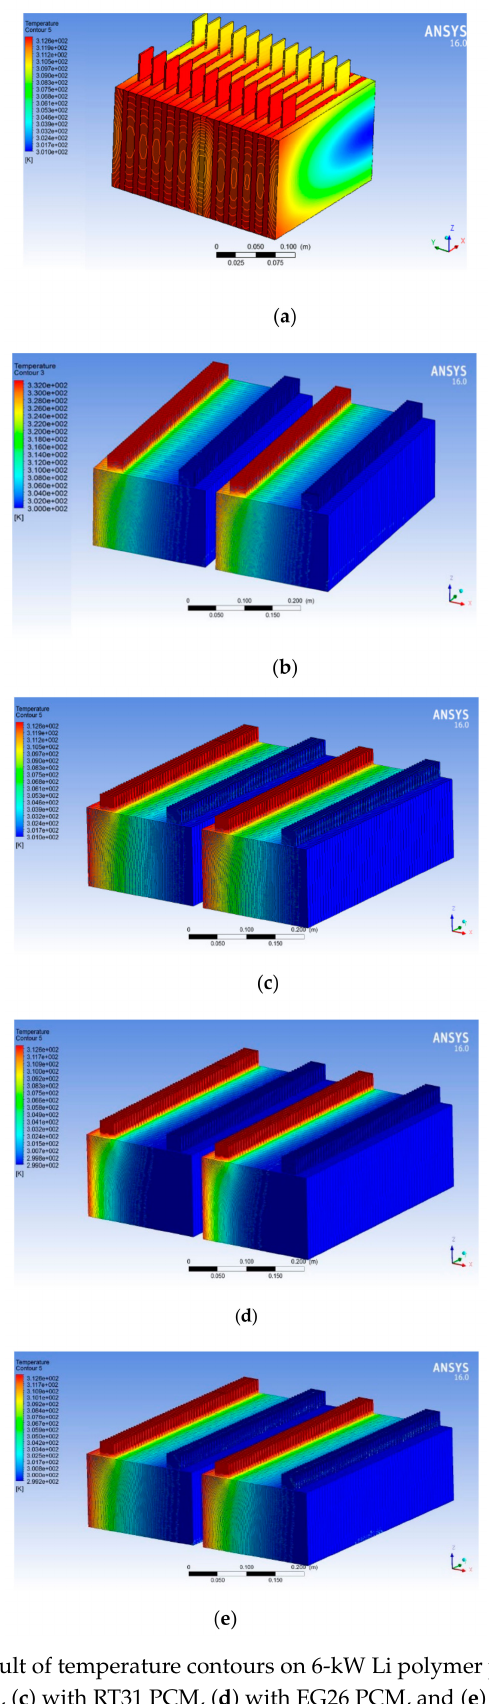
Figure 11. Simulation result of temperature contours on 6-kW Li polymer pouch battery ( a ) without PCM, ( b ) with RT15 PCM, ( c ) with RT31 PCM, ( d ) with EG26 PCM, and ( e ) with EG5